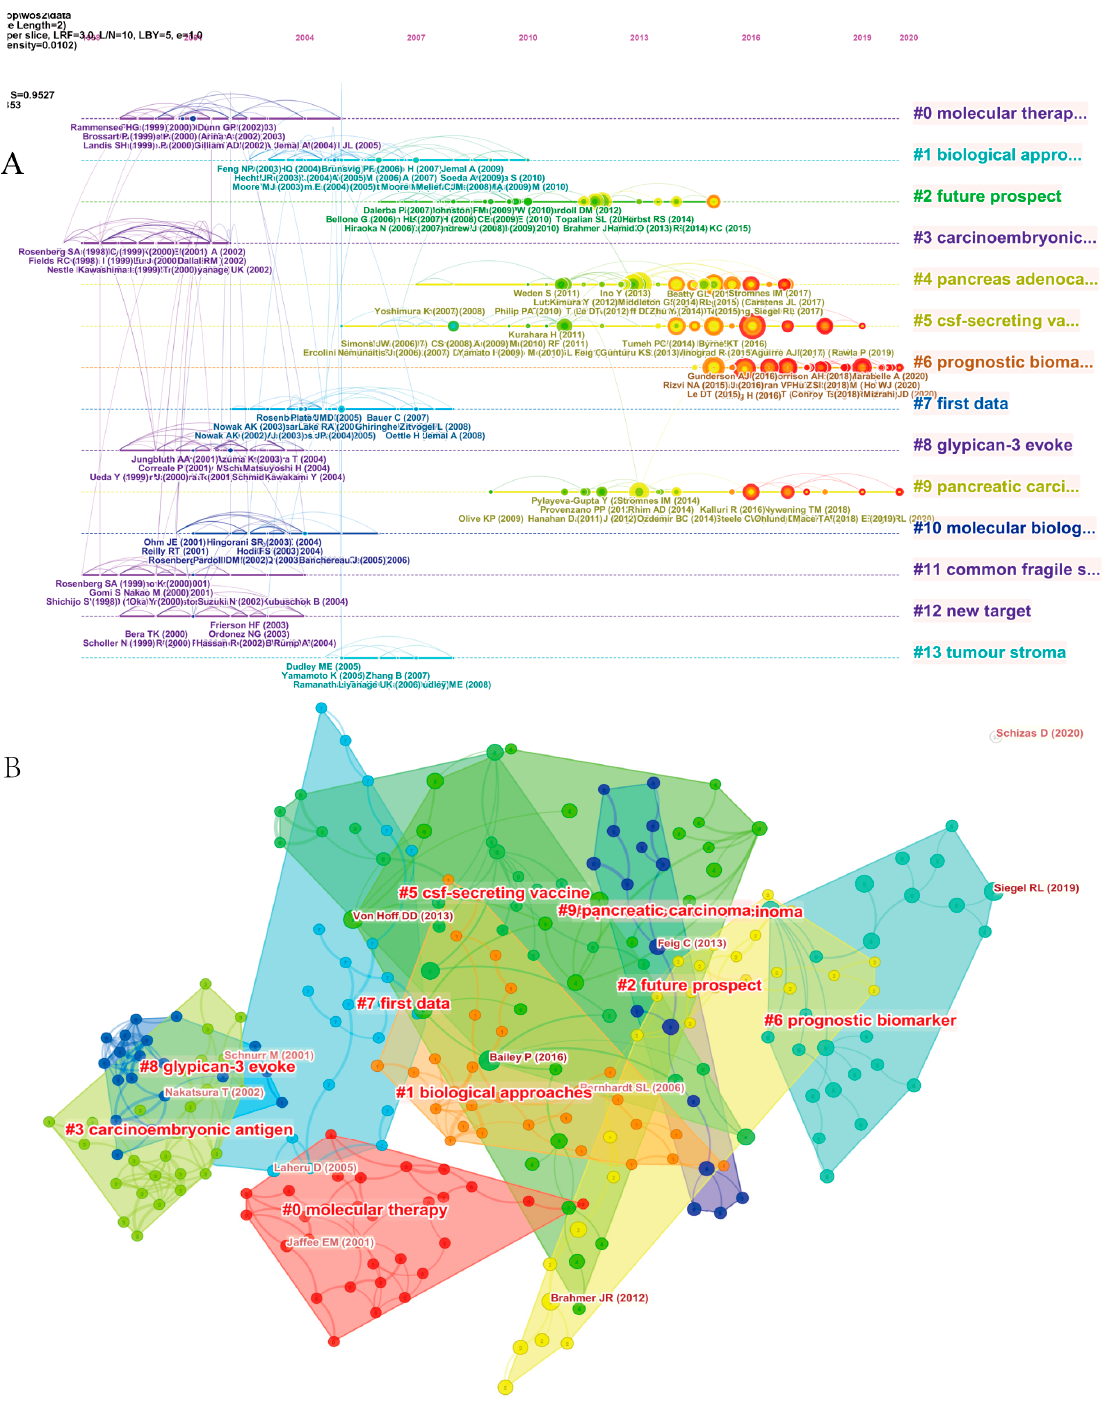
Figure 6. Timeline view ( A ) and cluster view ( B ) of co-citation references related to pancreatic cancer immunotherapy visualized by CiteSpace. Fifteen labeled clusters are colored on the right. The nodes on the line represented the cited